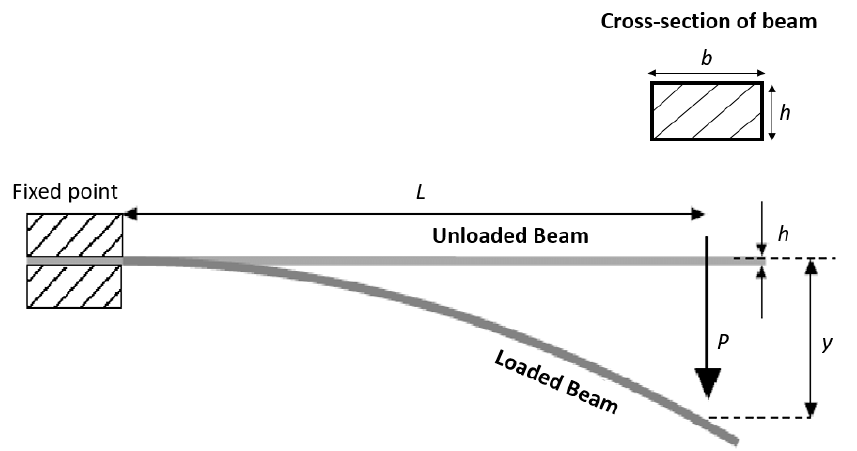
Figure 7. Schematic diagram of cross-arm structure when exposed applied force at the end of the cross-arm structure.